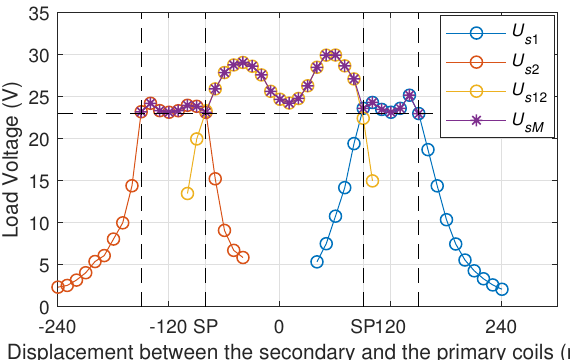
Figure 10. Two-to-one WPT prototype load voltage ( R L = 9.8 Ω ).